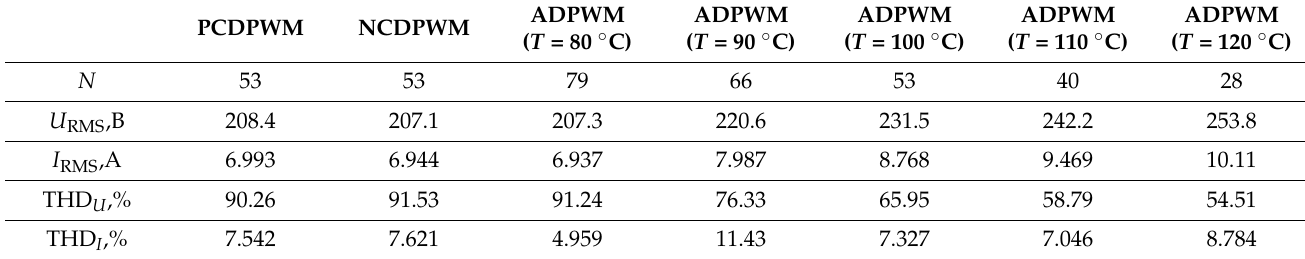
Table 4. Simulation results at MI =